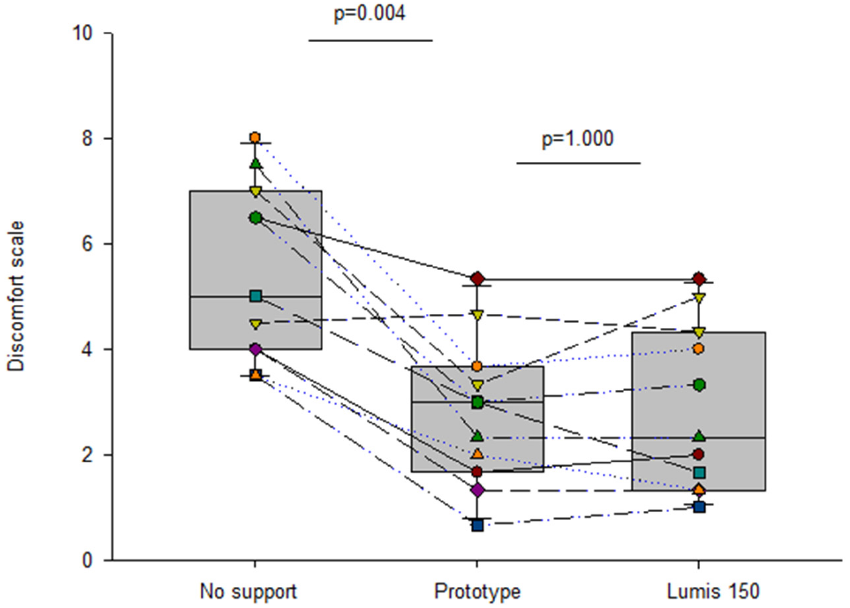
Figure 6. Discomfort scoring (Visual Analog Scale) in healthy volunteers subjected to obstructive–restrictive loaded breathing when unsupported and when supported by the prototype and Lumis 150 ventilators. Reprinted with permission from Ref. [11]. Creative Commons CC-BY license.